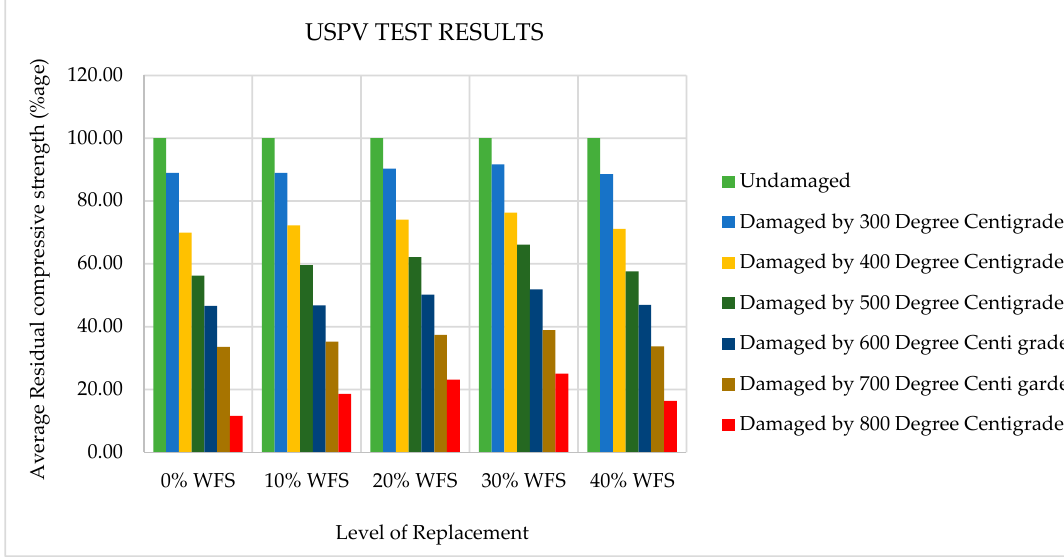
Figure 10. Variation in USPV values at elevated temperature levels.